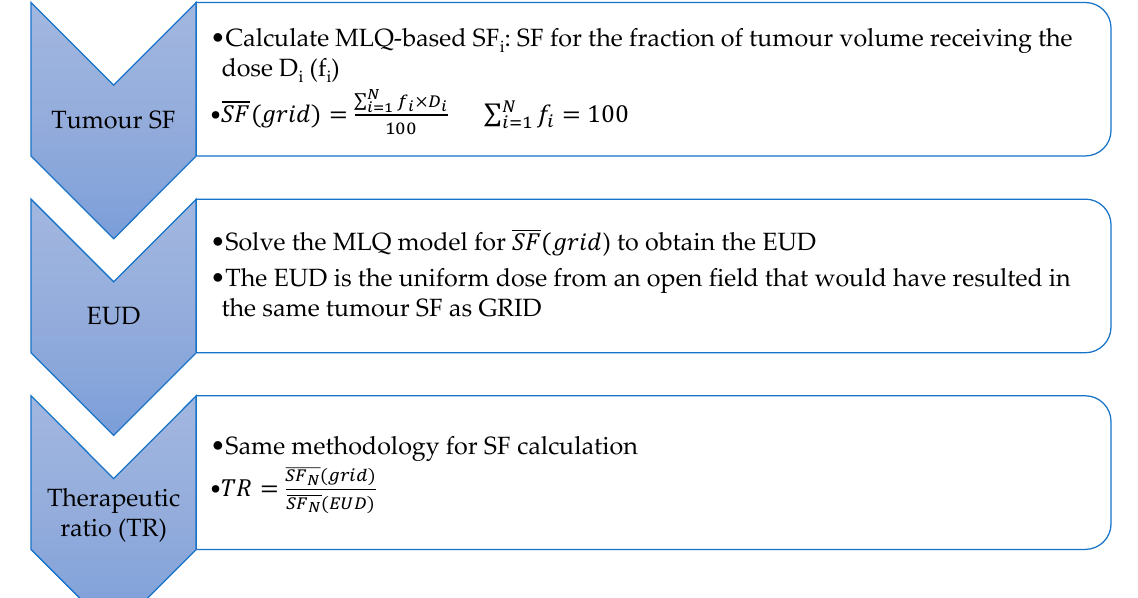
Figure 2. The diagram demonstrates the therapeutic ratio calculation process for GRID RT with photons [54].